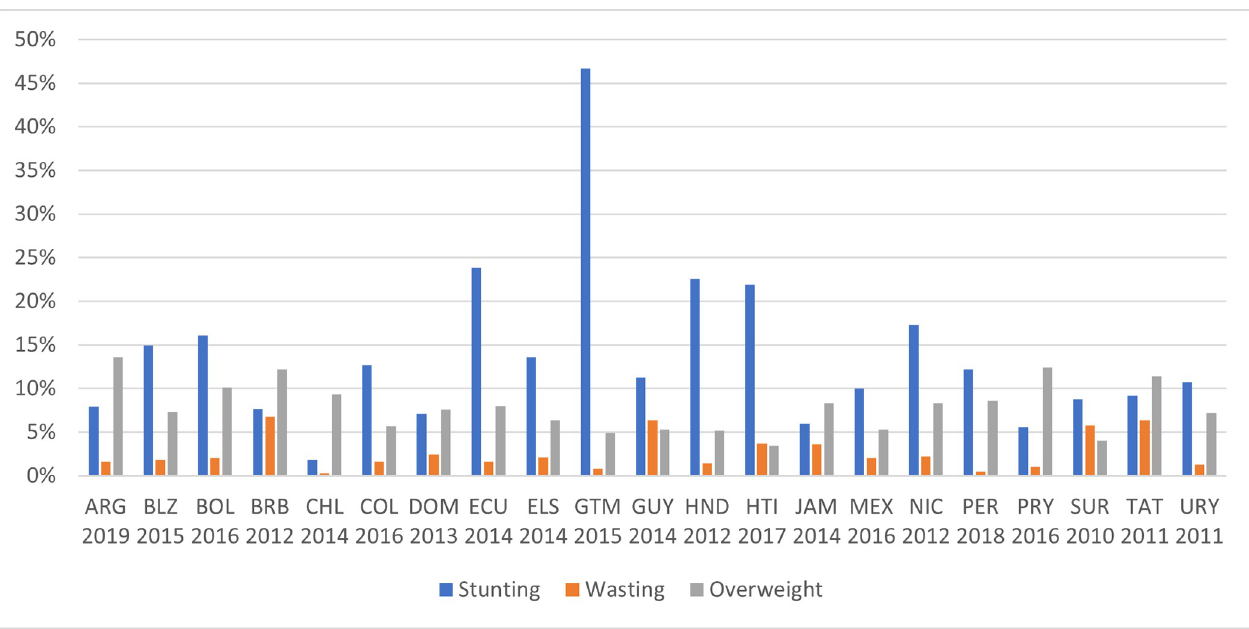
Fig 2. The prevalence of stunting, wasting and overweight in Latin American and the Caribbean countries. Note: The figure shows the prevalence of stunting, wasting and overweight for each country using the latest available data since 2010. Abbreviations: ARG: Argentina, BLZ: Belize, BOL: Bolivia, BRB: Barbados, CHL: Chili, COL: Colombia, DOM: Dominican Republic, ECU: Ecuador, ELS: El Salvador, GTM: Guatemala, GUY: Guyana, HND: Honduras, HTI: Haiti, JAM: Jamaica, MEX: Mexico, NIC: Nicaragua, PER: Peru, PRY: Paraguay, SUR: Suriname, TAT: Trinidad and Tobago, URY: Uruguay. Source: authors’ calculations based on UNICEF Global